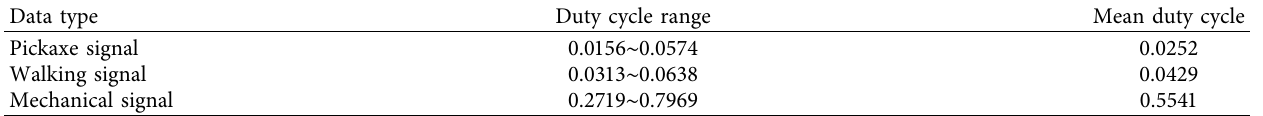
Table 1: Signal duty cycle